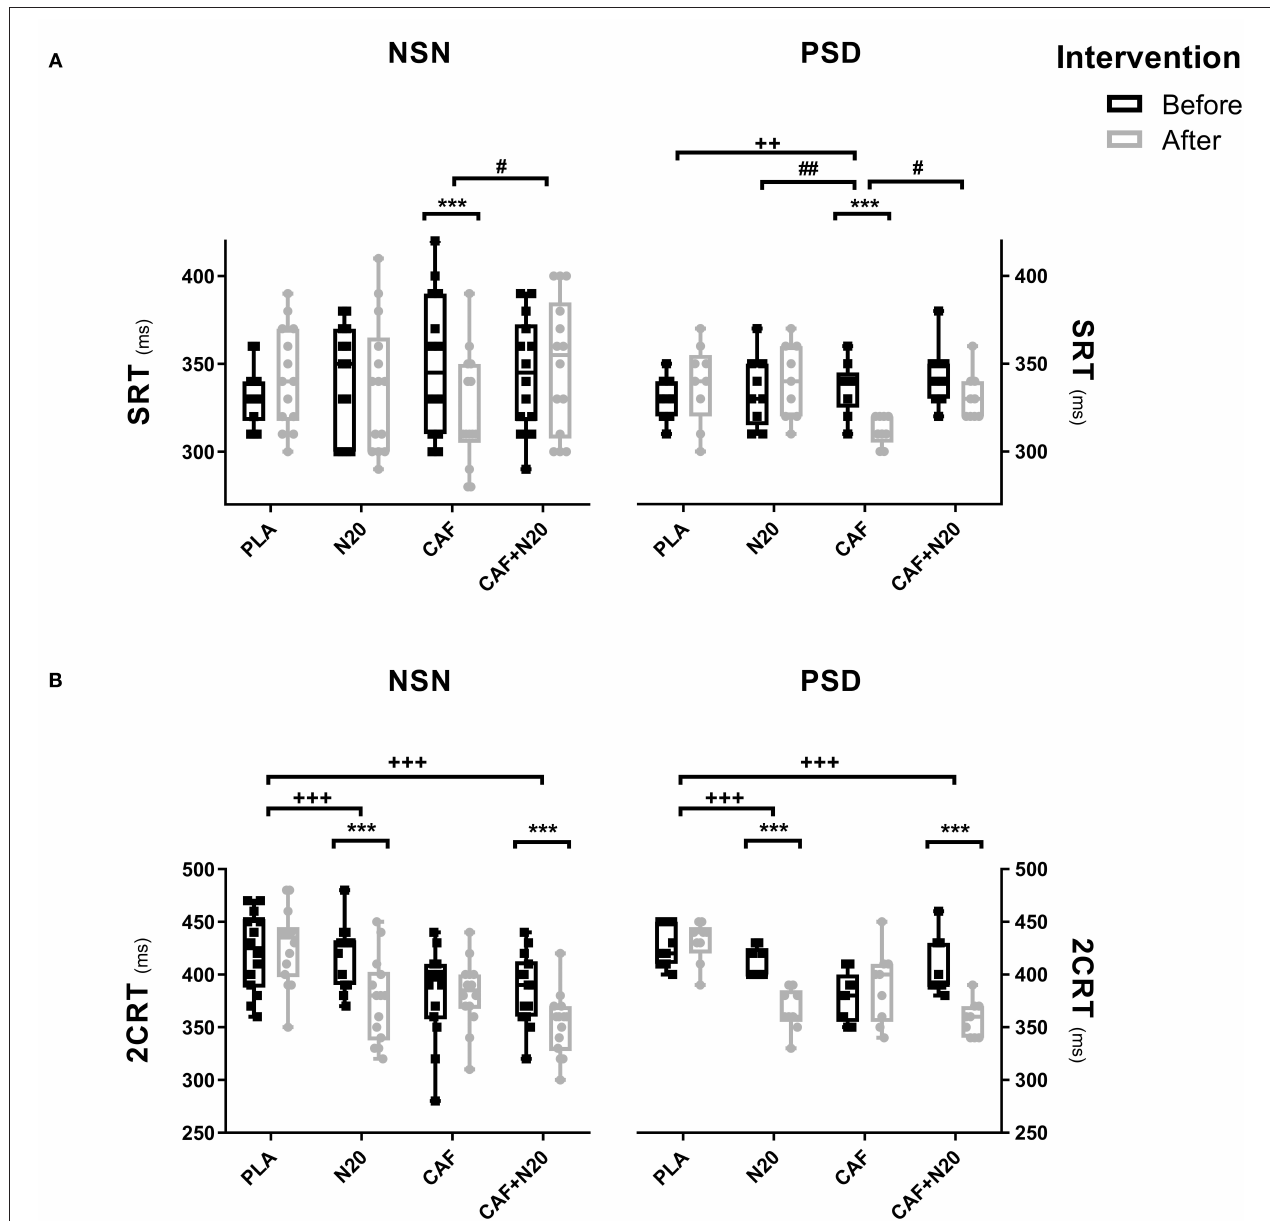
FIGURE 2 | Mean ± standard deviation of simple reaction time (SRT; A ) and two-choice reaction time (2CRT; B ) during different protocol sessions; PLA, placebo ingestion, N20, 20min nap with placebo ingestion, CAF, 5mg · kg − 1 of caffeine, CAF + N20, 5mg · kg − 1 of caffeine + 20min nap after a night of normal sleep (NSN; left panel) partial sleep deprivation (PSD; right panel), ms, milliseconds. Significance was determined using a Two-way repeated measure ANOVA. Significance for pairwise comparison is determined with Bonferroni post-hoc test. *, ** and *** presents a significant difference in comparison with pre-intervention values at p < 0.05, p < 0.01 and p < 0.001 respectively, + , ++ and +++ presents a significant difference in comparison with PLA values at p < 0.05, p < 0.01 and p < 0.001 respectively, # , ## and #### presents a significant difference in comparison with CAF values at p < 0.05, p < 0.01 and p < 0.001 respectively. µ presents a significant difference in comparison with N20 values at p <